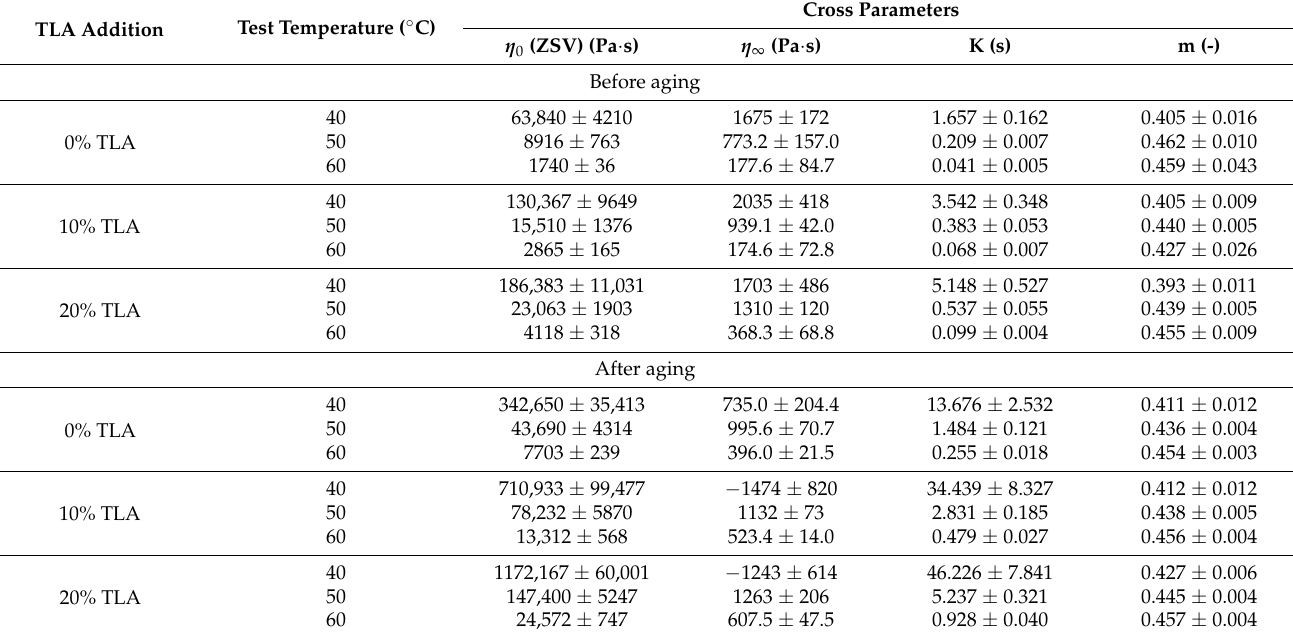
Table 6. Cross parameters of the TLA-modified binders before and after